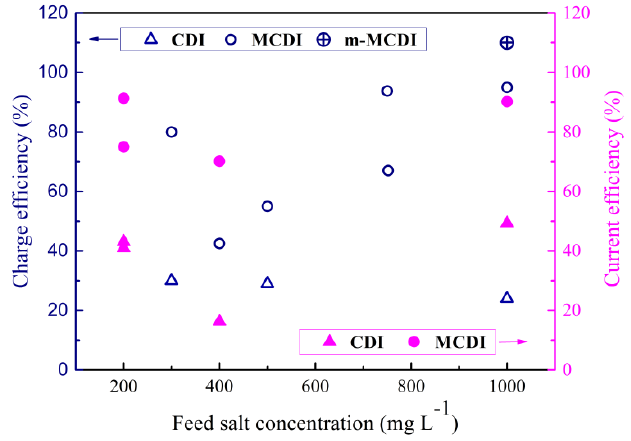
Figure 5. Charge and current efficiencies as a function of feed salt concentration for a range of recent studies